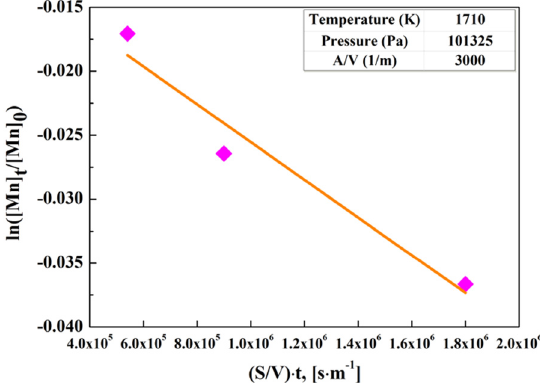
Figure 3: Variation of manganese volatilization rate constant at di ff erent